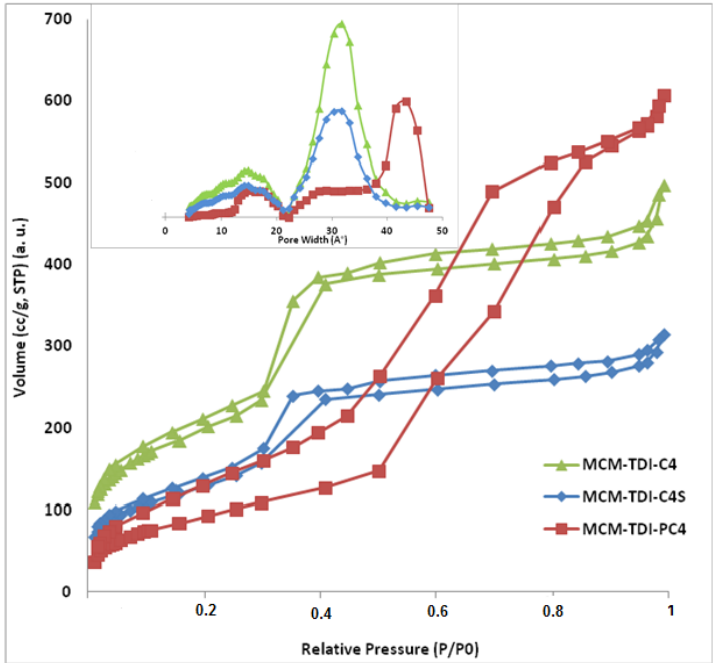
Figure 3. Nitrogen adsorption-desorption isotherms and pore size distribution of